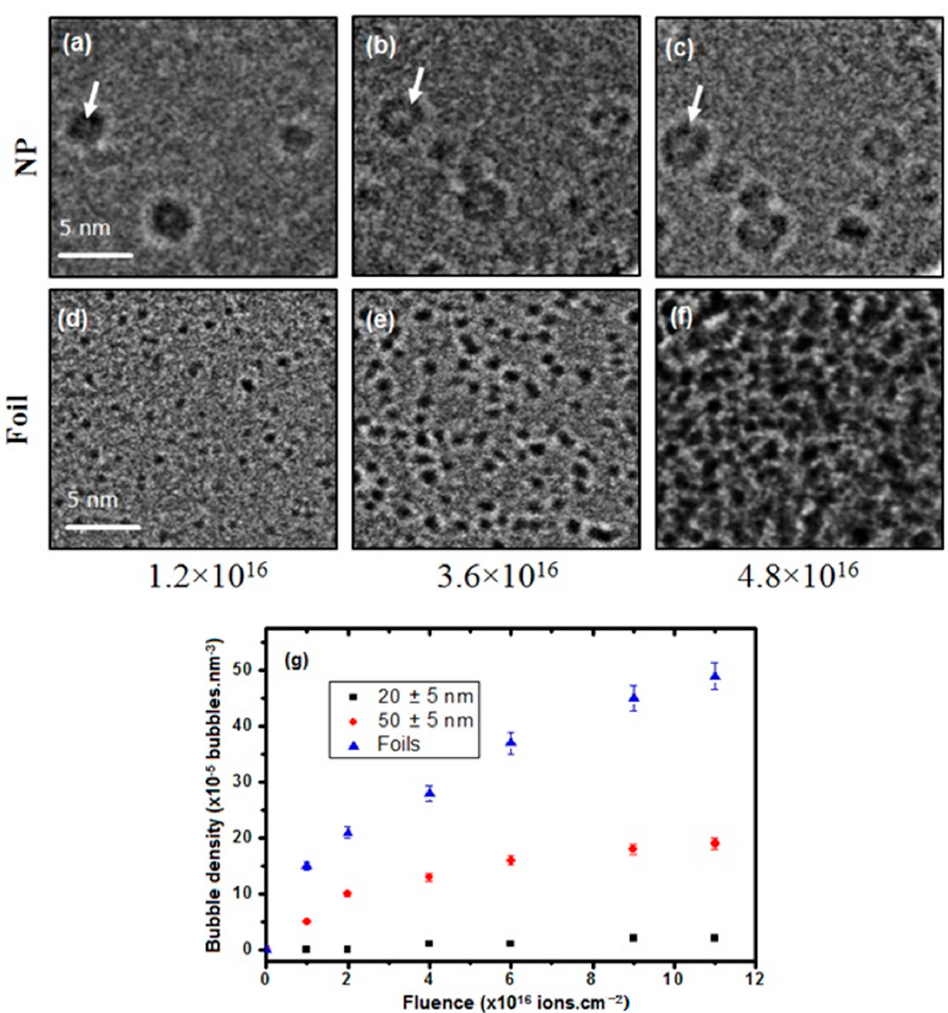
Figure 3. BF-TEM images comparing bubbles in a 35 nm diameter W NP ( a – c ) and foil ( d – f ) as a function of fluence taken at 400 nm overfocus. The arrows in a – c highlight the growth of a bubble in the NP as the fluence increases. (Scale marker in ( a ) and ( d ) applies to all images.) Figure ( g ) shows the relationship between bubble density and fluence for NPs with diameters of 20 ± 5 and 50 ± 5 nm in the foil.